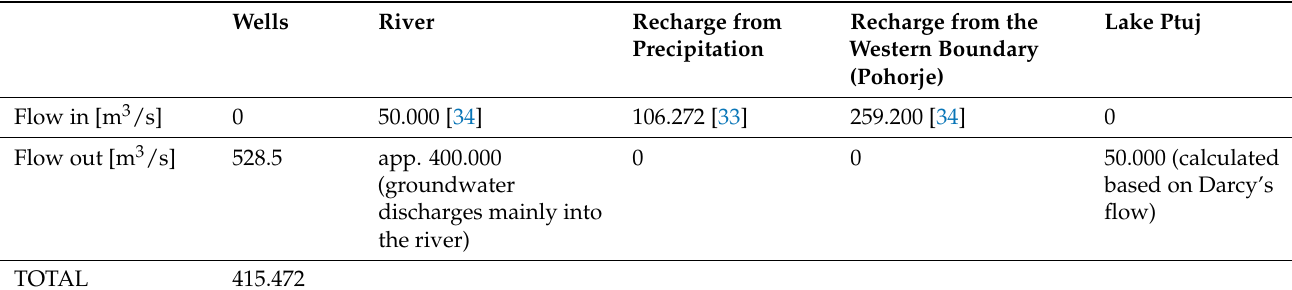
Table 1. Estimation of the Dravsko polje aquifer groundwater flow.